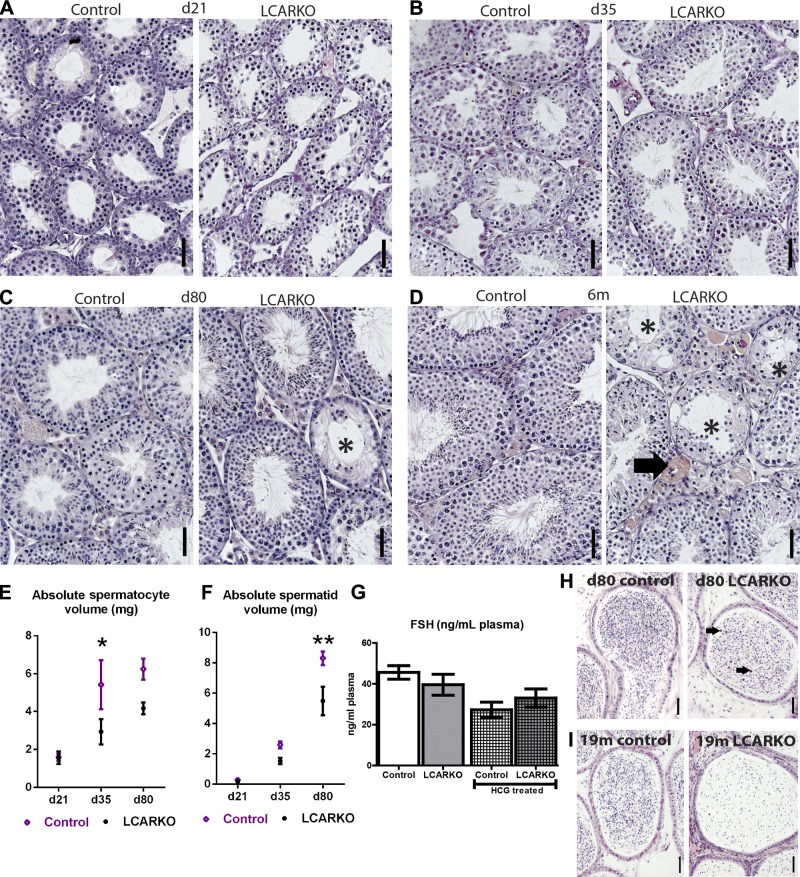
LCARKO mice have degenerative testicular histology. A) Testicular histology is similar between LCARKOs and controls at d 21. B) Testicular histology is similar between LCARKOs and controls at d 35. C) At d 80, LCARKO testes show foci of seminiferous epithelium degeneration (asterisk), whereas controls still appear normal. D) At 6 mo of age, foci of seminiferous epithelium degeneration are more widespread in the LCARKO (asterisks), which also have large pink/orange-staining multinucleate cells in the interstitium (arrow). Testes from controls are unaffected. E) LCARKOs have a reduction in testicular spermatocyte volume at d 35 (5.4 mg control; 3.0 mg LCARKO; *P < 0.05) and d 80 (6.3 mg control; 4.2 mg LCARKO) compared to controls. Error bars, sem. F) LCARKOs have a reduction in testicular spermatid volume compared to controls at d 35 (2.6 mg control; 1.5 mg LCARKO) and d 80 (8.3 mg control; 5.5 mg LCARKO; **P < 0.01). Error bars, sem. G) FSH levels are normal in LCARKO compared to controls at d 80 and for hCG treated at d 100. Error bars, sem. H) Spermatozoa are present in the cauda epididymis of both controls and LCARKOs at d 80, but immature round sloughed germ cells are also seen in the LCARKO (arrows). I) Fewer spermatozoa are present in the cauda of LCARKOs than controls at 19 mo. Scale bars, 50 µm.